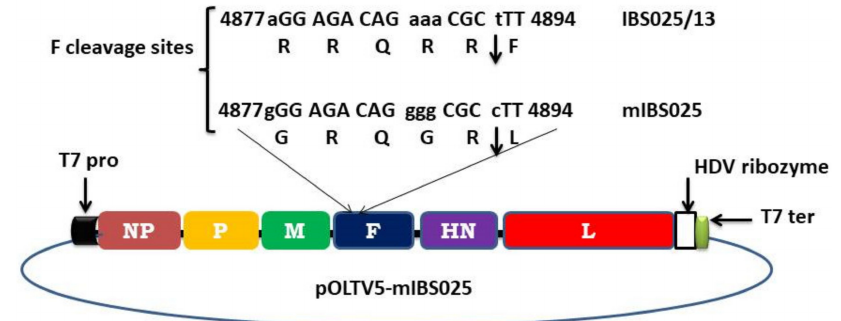
Figure 2. Construction of full length antigenomic clone of NDV mIBS025. Complete genome of the wild type NDV IBS025 / 13 was modified in silico at the fusion (F) protein cleavage site (4877–4894 bp) to generate monobasic amino acid residues at the site. Substituted nucleotides are shown in lower cases and the location of the cleavage is indicated by an arrow between the amino acids. The modified antigenome (NDV mIBS025) was synthesized and cloned in pOLTV5 transcription vector in between T7 promoter and autocatalytic hepatitis delta virus ribozyme sequence to produce pOLTV5-mIBS025 full length antigenomic construct.